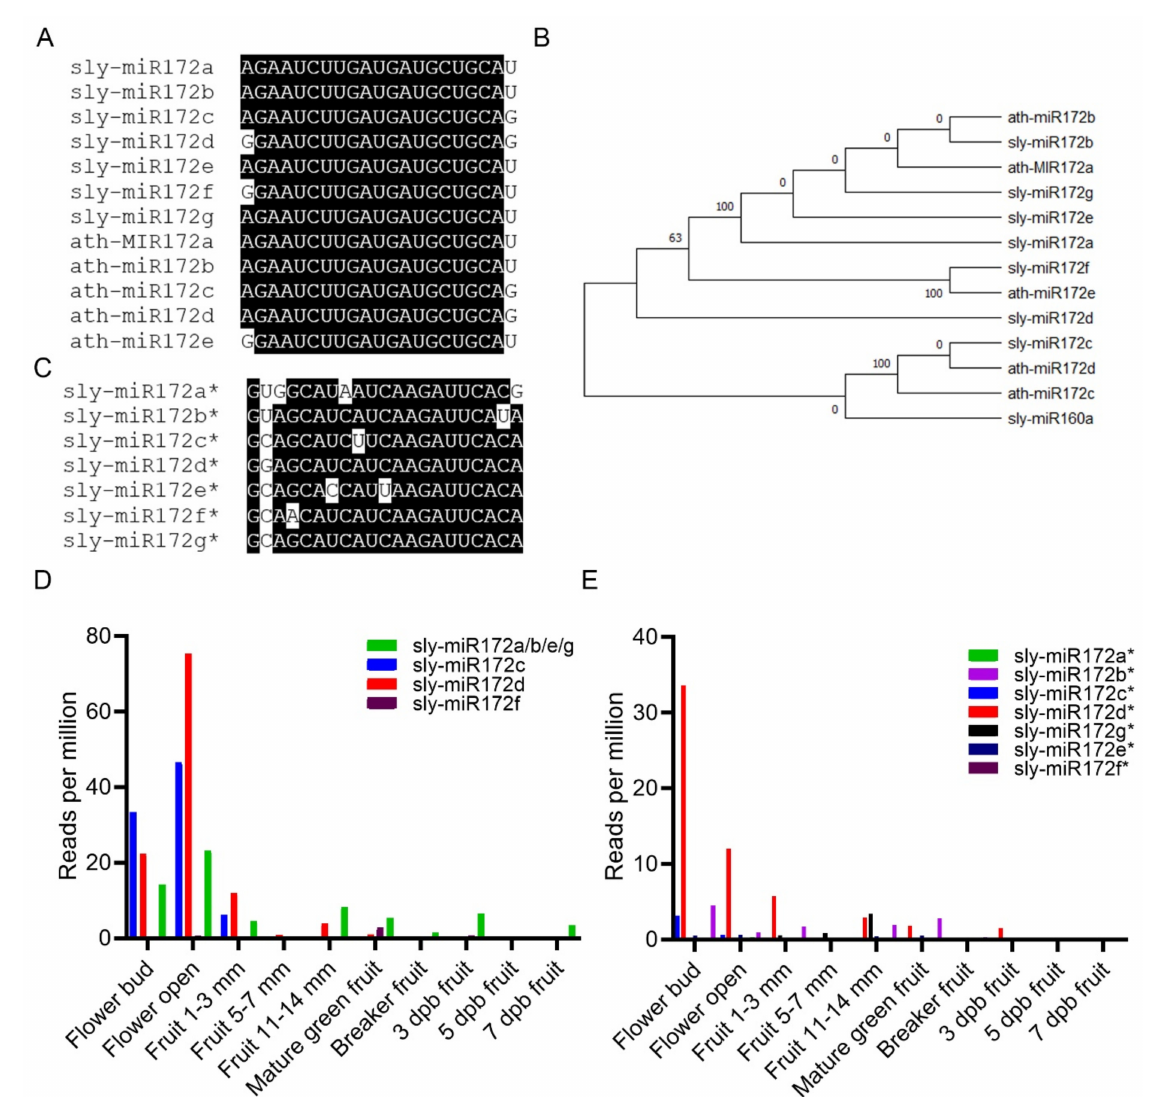
Figure 1. The tomato miR172 family. ( A ) Nucleotide sequence alignment of Arabidopsis (ath-miR172) and tomato (sly-miR172) miR172 family members. ( B ) A rooted phylogenetic tree based on the Arabidopsis and tomato miR172 family members. Sly- miR160a served as an outgroup. The tree was constructed using FastTree v2.1.8 with default parameters [34]. ( C ) Nucleotide sequence alignment of tomato miR172 members star strands. ( D , E ) Accumulation of sly-miR172 members mature ( D ) and star ( E ) strands in tomato cv. MicroTom anthesis flowers and pericarp of developing fruits as indicated. Mature sly-miR172a, sly-miR172b, sly-miR172e and sly-miR172g have identical sequences hence the single profile (sly-miR72a/b/e/g). The expression data was retrieved from the Tomato Functional Genomics Database (http://ted.bti.cornell.edu/, accessed on 1 January 2021). dpb-days post